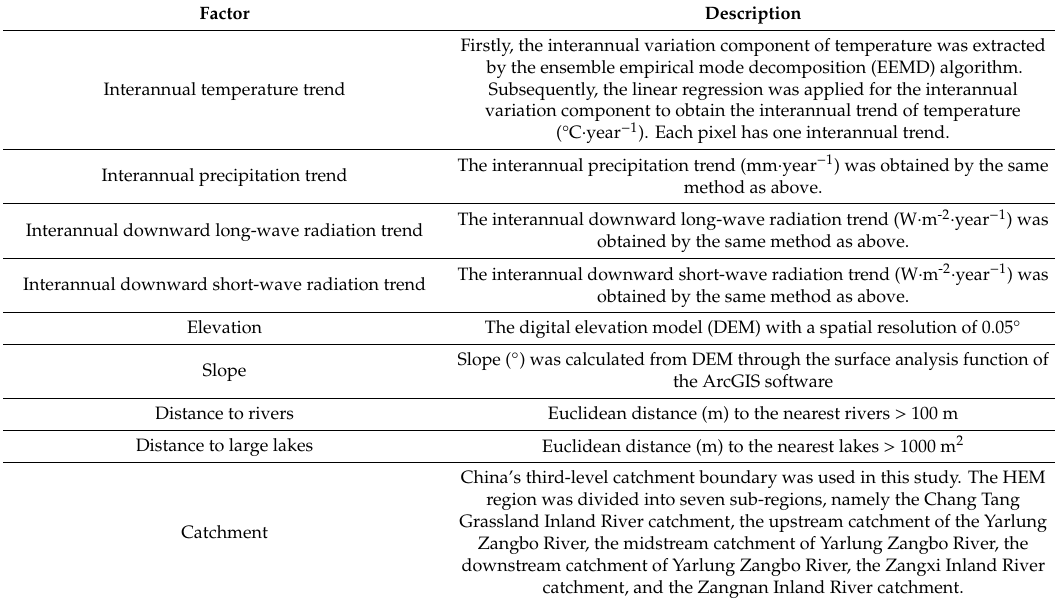
Table 1. Preprocessing of the nine environmental factors for the Random Forest